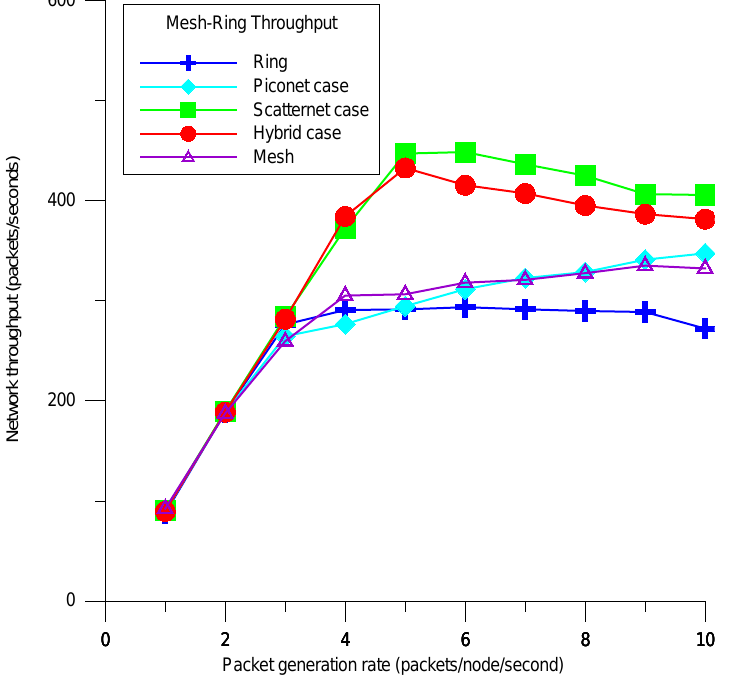
Figure 10. The network throughput performance of the RMR algorithm.